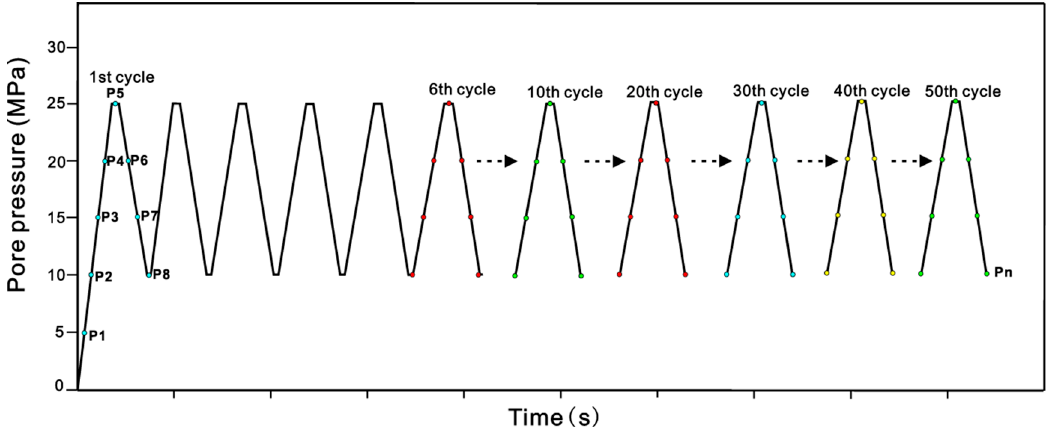
Figure 5. NMR experimental schematic during different cycles of fluid injection and extraction process (P n -measuring points).